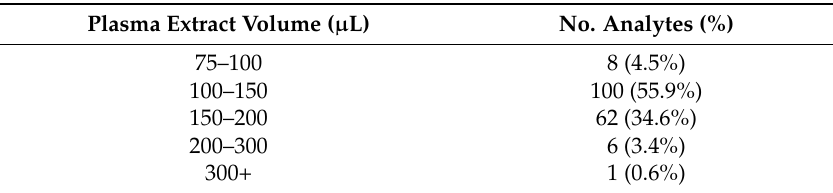
Table 3. Linear dynamic range for all analytes. The majority (90.5%) of analytes’ linear range was between 100 and 200 µL.